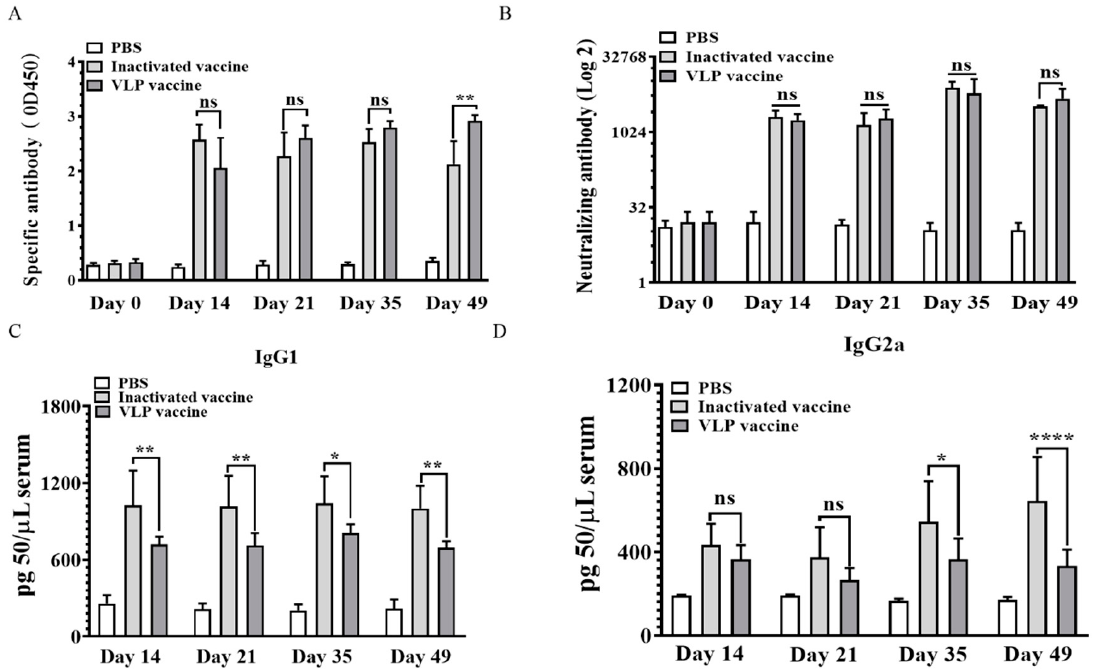
Figure 3. Detection of serum antibodies. ( A ) Specific antibodies; ( B ) neutralizing antibodies; ( C ) IgG1 antibodies; ( D ) IgG2a antibodies. Levels of serum antibody detected in pigs vaccinated with SVA VLPs ( n = 5), inactivated vaccines ( n = 5) and PBS ( n = 5) at 0 days, 14 days, 21 days, 35 days and 49 days post-immunization (ns were considered no statistically significant, * p < 0.05, ** p < 0.01, **** p < 0.0001). The degrees of cellular immune responses (Th1) and humoral immune responses (Th2) are represented by the levels of IgG2a and IgG1 antibodies, respectively. Serum IgG1 and IgG2a